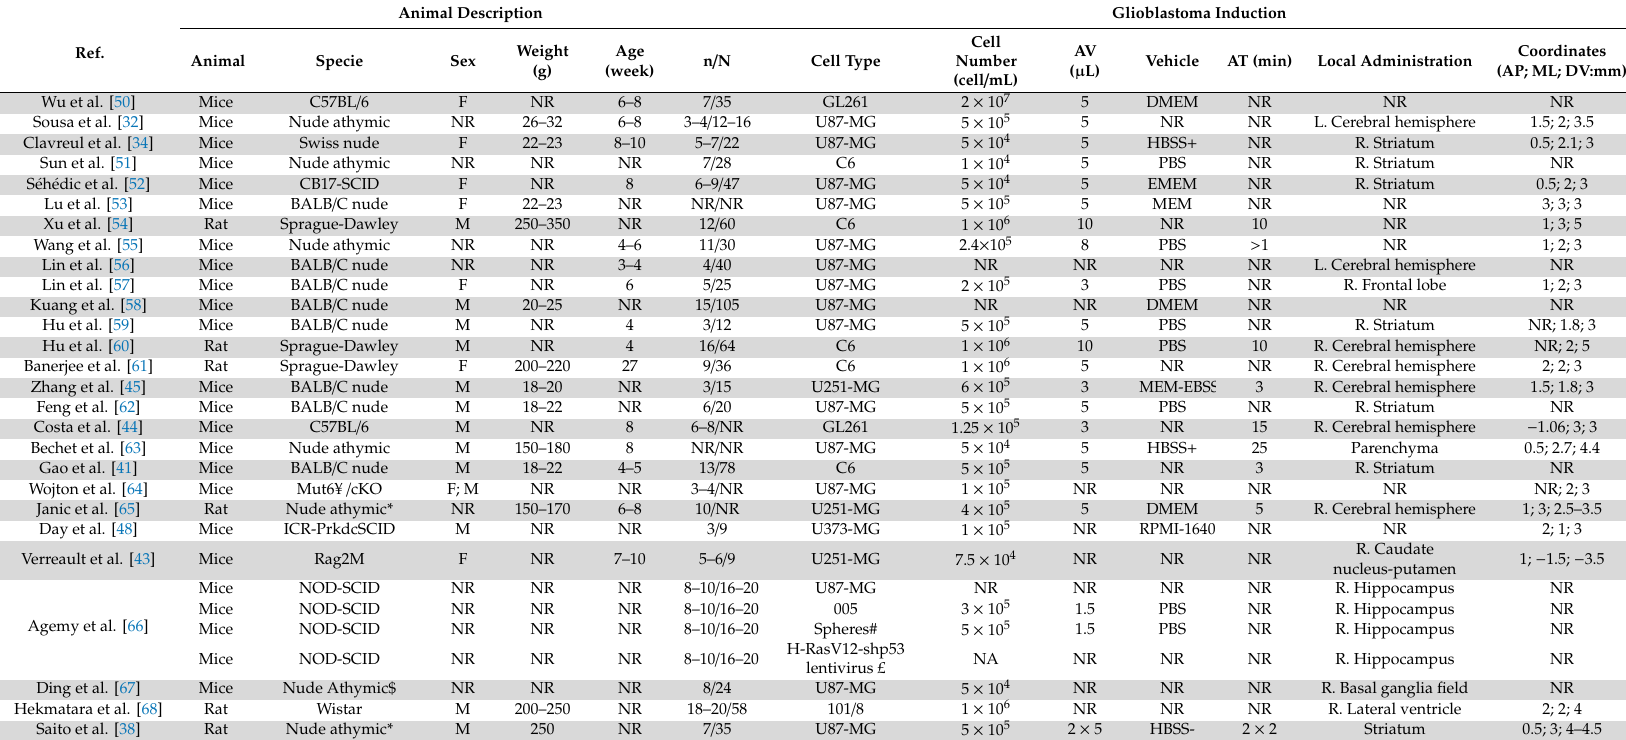
Table 2. Glioblastoma induction model